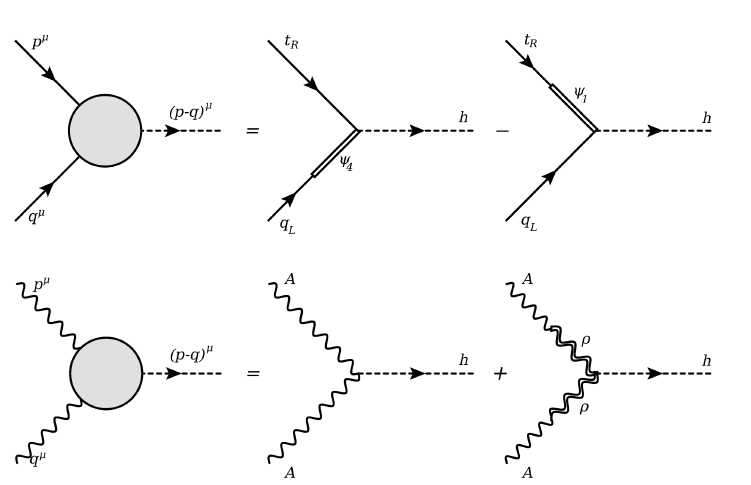
Figure 3 . Dynamical Higgs couplings to fermions and gauge bosons in the MCHM 5